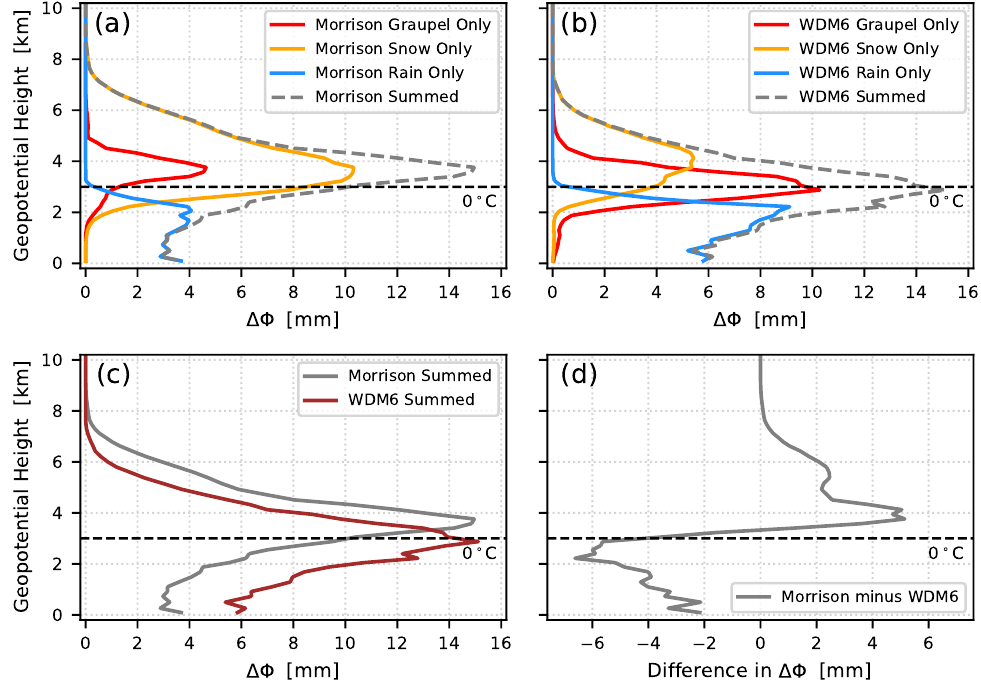
Figure 11. Simulated profiles of polarimetric differential phase delay for occultation g03r, calculated individually for rain, snow, and graupel as well as for their combined sum for the ( a ) Morrison and ( b ) WDM6 experiments. Comparison of ( c ) the full polarimetric differential phase delay for the two experiments, as well as ( d ) the difference ∆Φ Morrison − ∆Φ WDM 6 between the two experiments. The black dashed line indicates the freezing level in the corresponding